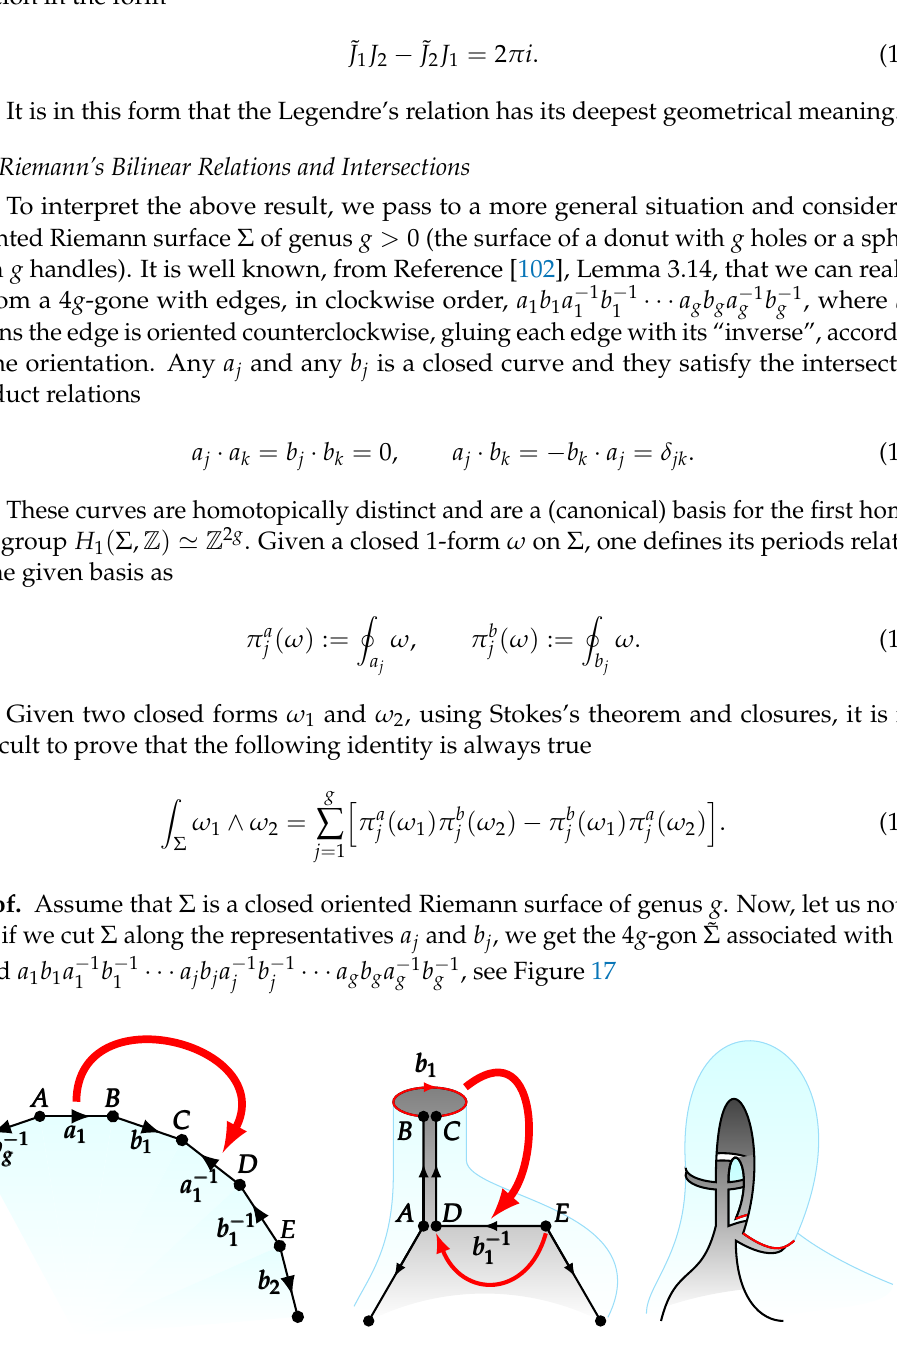
Figure 17. Riemann surfaces from the fundamental 4 g -gon.